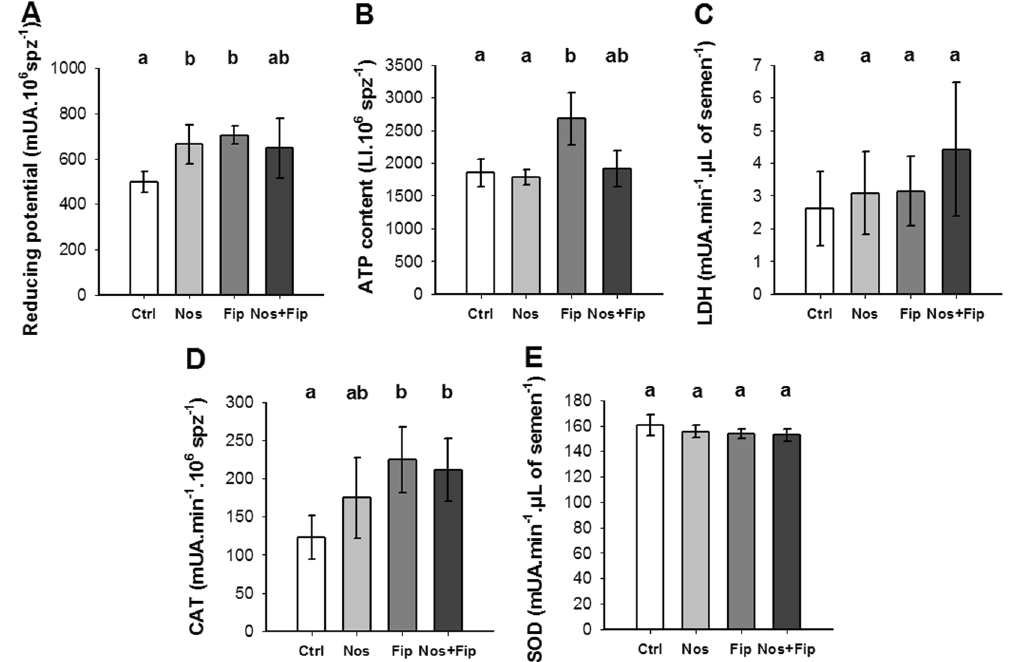
Figure 4. Effects of the stressors, alone or combined, on physiological markers in semen. Physiological markers were studied in semen. The reducing potential ( A ) and ATP content ( B ) in semen and the LDH activity in seminal fluid ( C ) were measured to assess the effects of each treatment on sperm metabolism. The CAT activity in spermatozoa (spz) ( D ) and the SOD activity in seminal fluid ( E ) were measured to assess the antioxidant response. The data represent the mean values ± standard deviations of the parameters expressed in milliUnits of Absorbance (mUA) for Red Pot, LDH, CAT and SOD, or in Luminescence Intensity (LI) for ATP (n = 4 for each modality of treatment). Statistical analyses were performed using a post-hoc Wilcoxon test. Significant differences at P ≤ 0.05 between modalities are expressed with different